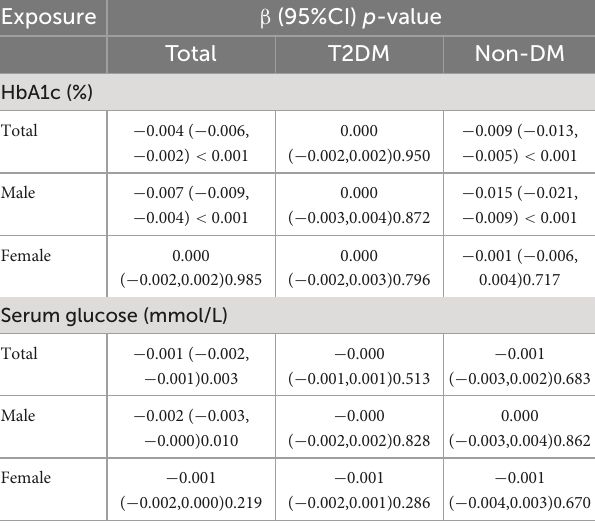
TABLE 4 Association between ASM BMI , sarcopenia, and diabetes status. TABLE 5 Association of HbA1c, and serum glucose with ASM BMI .